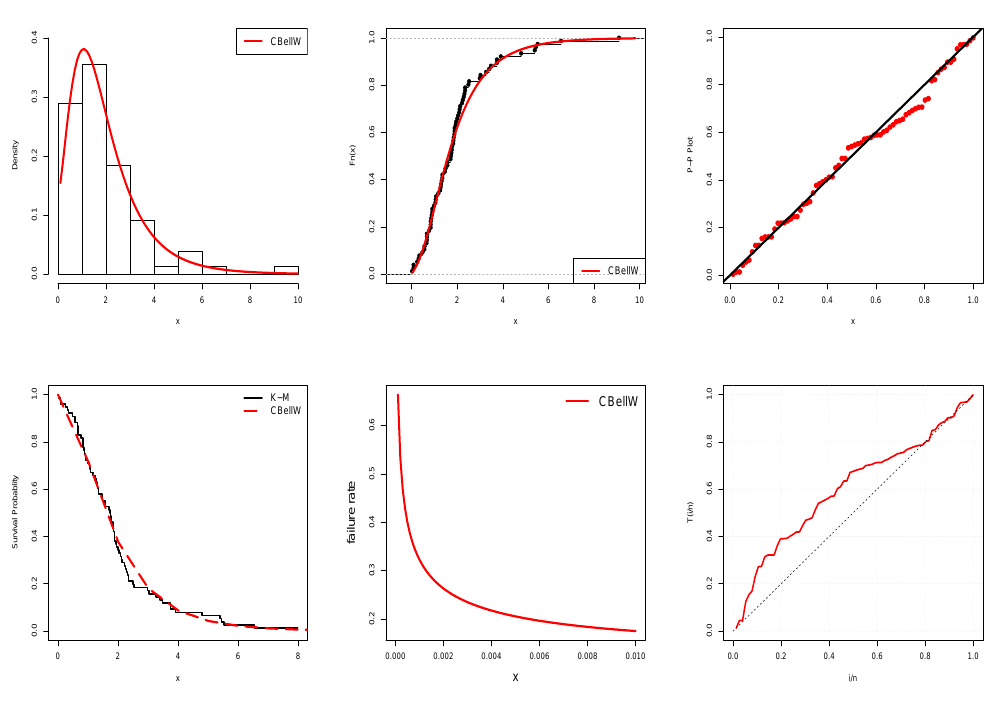
Figure 2. Graphical illustration of estimated plots under CBellW model of data-1.